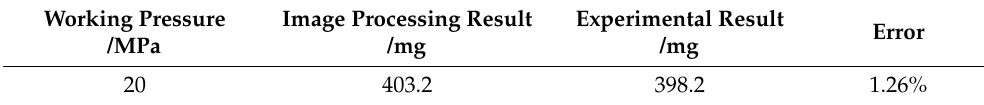
Figure 11. Mass loss of the sample at a working pressure of 20 MPa. Table 4. Comparison of the image processing result with the experimental result.